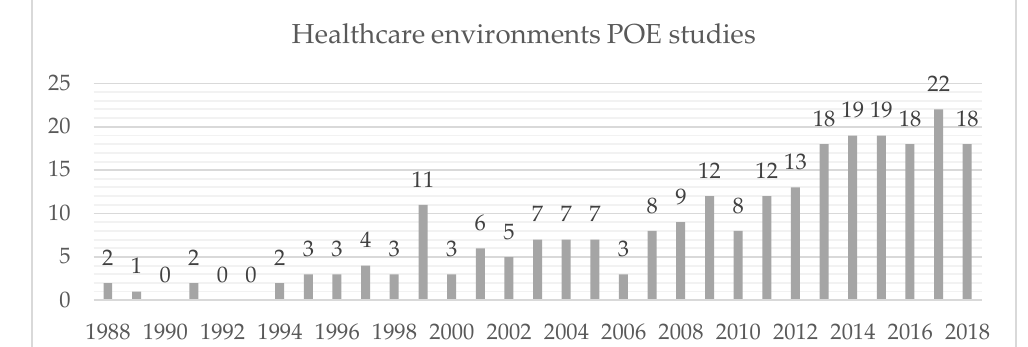
Figure 1. Number of Post Occupancy Evaluation (POE) studies or reviews published with focus on healthcare environments. The graph shows the there is a growing interest into the topic. The complete list and search process are available in Table S1.